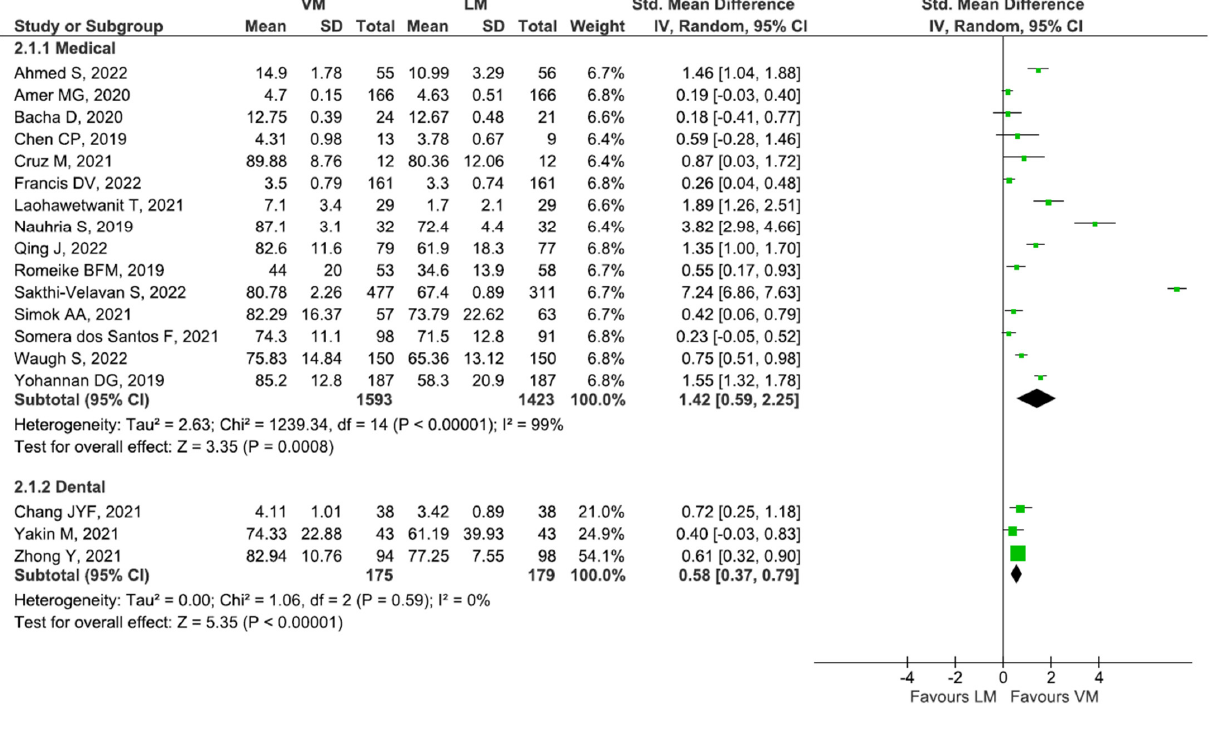
Figure 4. Overall analysis of 15 studies assessing exam performance among medical students [20,31–33,35,44,45,50,52,57,59,60,63,64]. A subgroup analysis on studies of low risk or bias compared to higher risk of bias was also performed based on the results of the NOS scale (Figure 5).